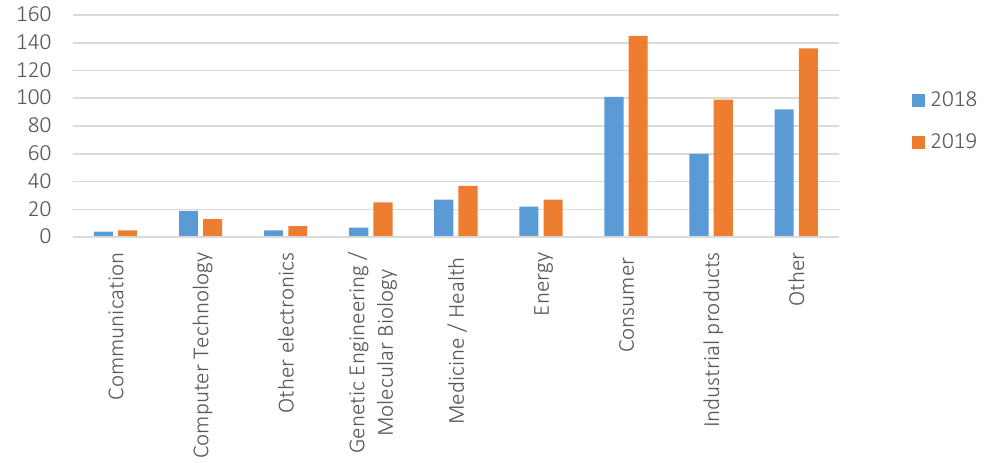
Figure 2. The number of profiles of domestic business entities in the EEN system that are interested in cooperation with entities from other countries for 2018 – first half of 2019